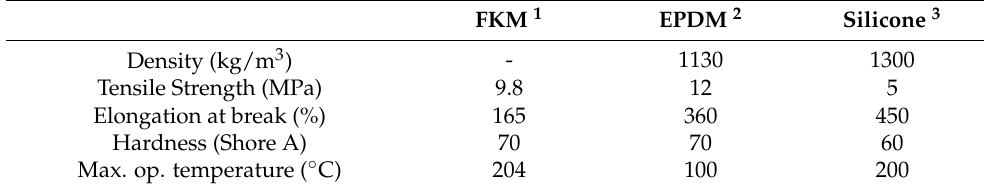
Table 2. Properties of the elastomers.